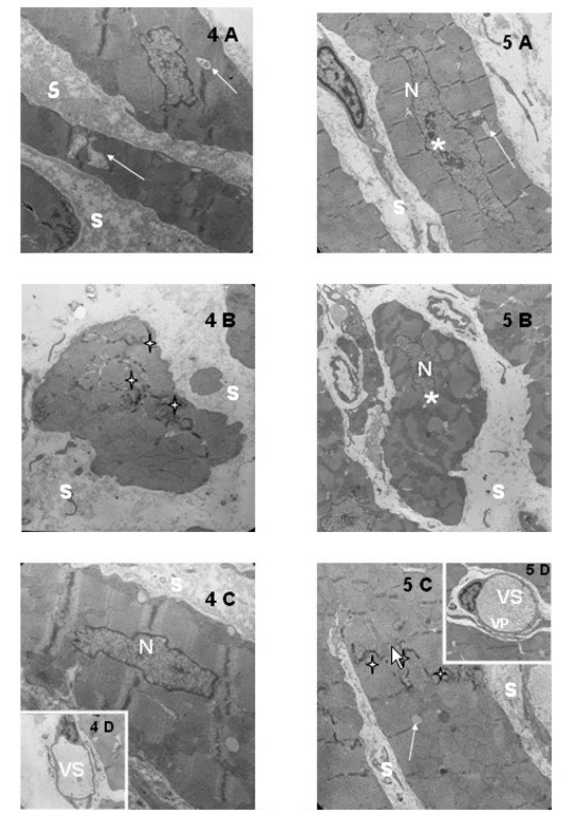
Fig. 4 - Eletromicrografias do miocárdio hipertrofiado de coelho, submetidos à parada sem proteção miocárdica (grupo controle). Cardiomiócitos com sinais de degeneração citoplasmática (setas), marginalização do disco intercalar (estrela), compactação periférica da cromatina, pregueamento nuclear (N), retração celular gerando aumento do espaço intercelular (S), vasos sangüíneos levemente dilatados, com paredes extremamente finas e poucas vesículas de pinocitose (VS). A: 4A = 4646x; 4B = 10000x; 4C = 21560x; 4D = 16700x Fig. 5 - Eletromicrografias do miocárdio hipertrofiados de coelho, submetidos à parada com cardioplegia cristalóide intermitente e fria (grupo experimental II). Miocárdio preservado, pequenas áreas de necrose (setas), menor retração dos cardiomiócitos, promovendo um menor espaço intercelular (S), discos intercalares preservados (estrela), núcleos (N) com nucléolo evidente (*), vasos sangüíneos (VS) com paredes espessadas, com maior quantidade de vesículas de pinocitose (VP). A: 5A = 6000x; 5B = 4646x; 5C = 7750x; 5D